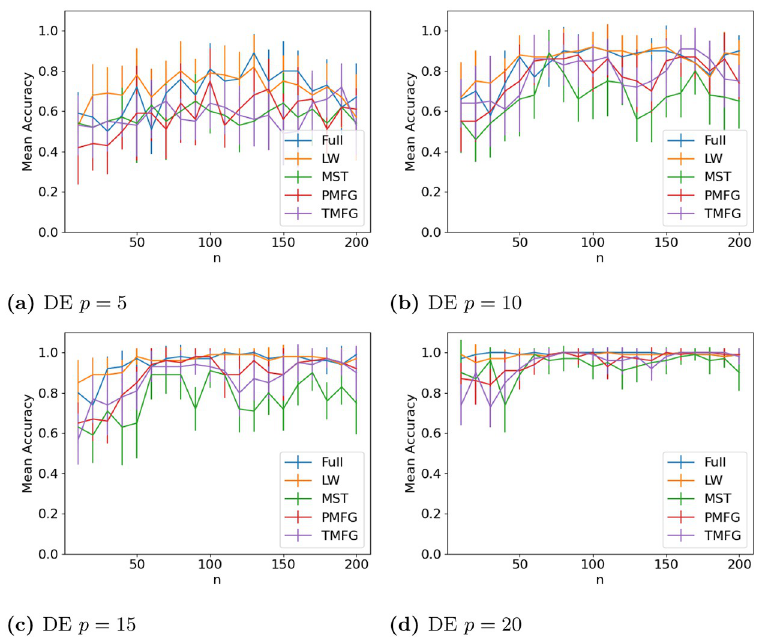
Fig 12. Accuracy when distinguishing between correlation matrices created from the stock windows with the maximum and minimum volatility using the SF method and a random forest classifier for Germany. (a) DE p = 5, (b) DE p = 10, (c) DE p = 15, (d) DE p = 20.